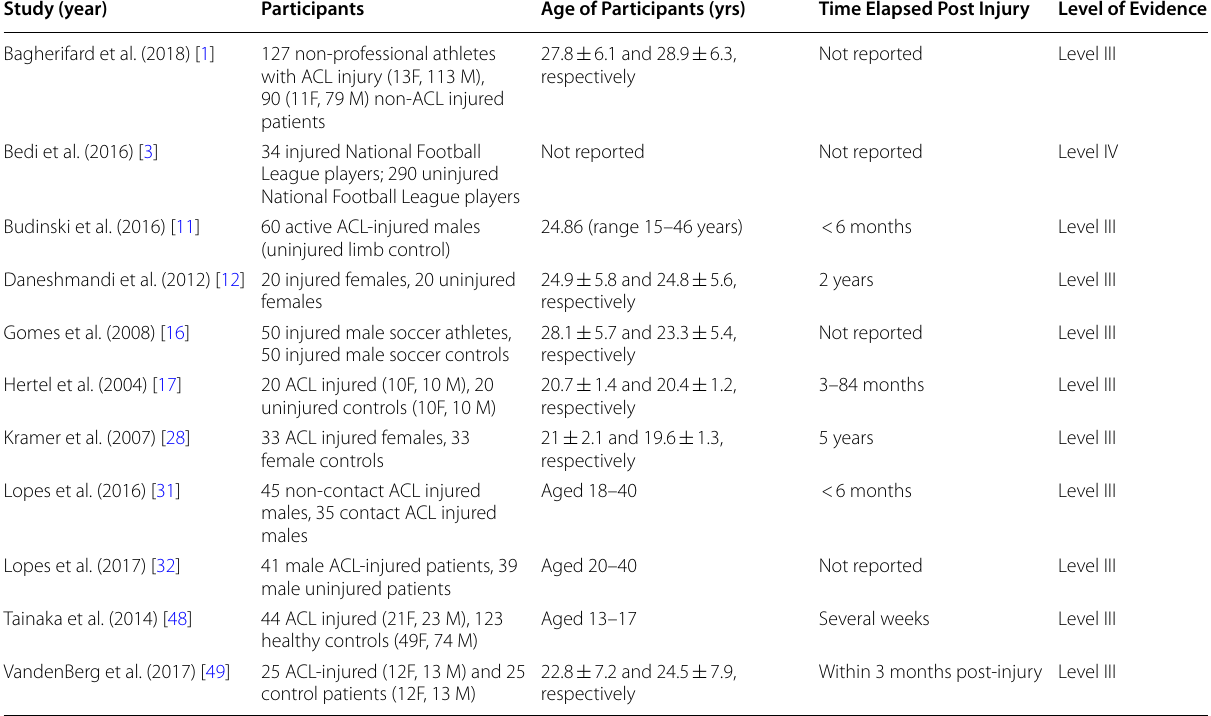
Table 2 Characteristics of included injury studies